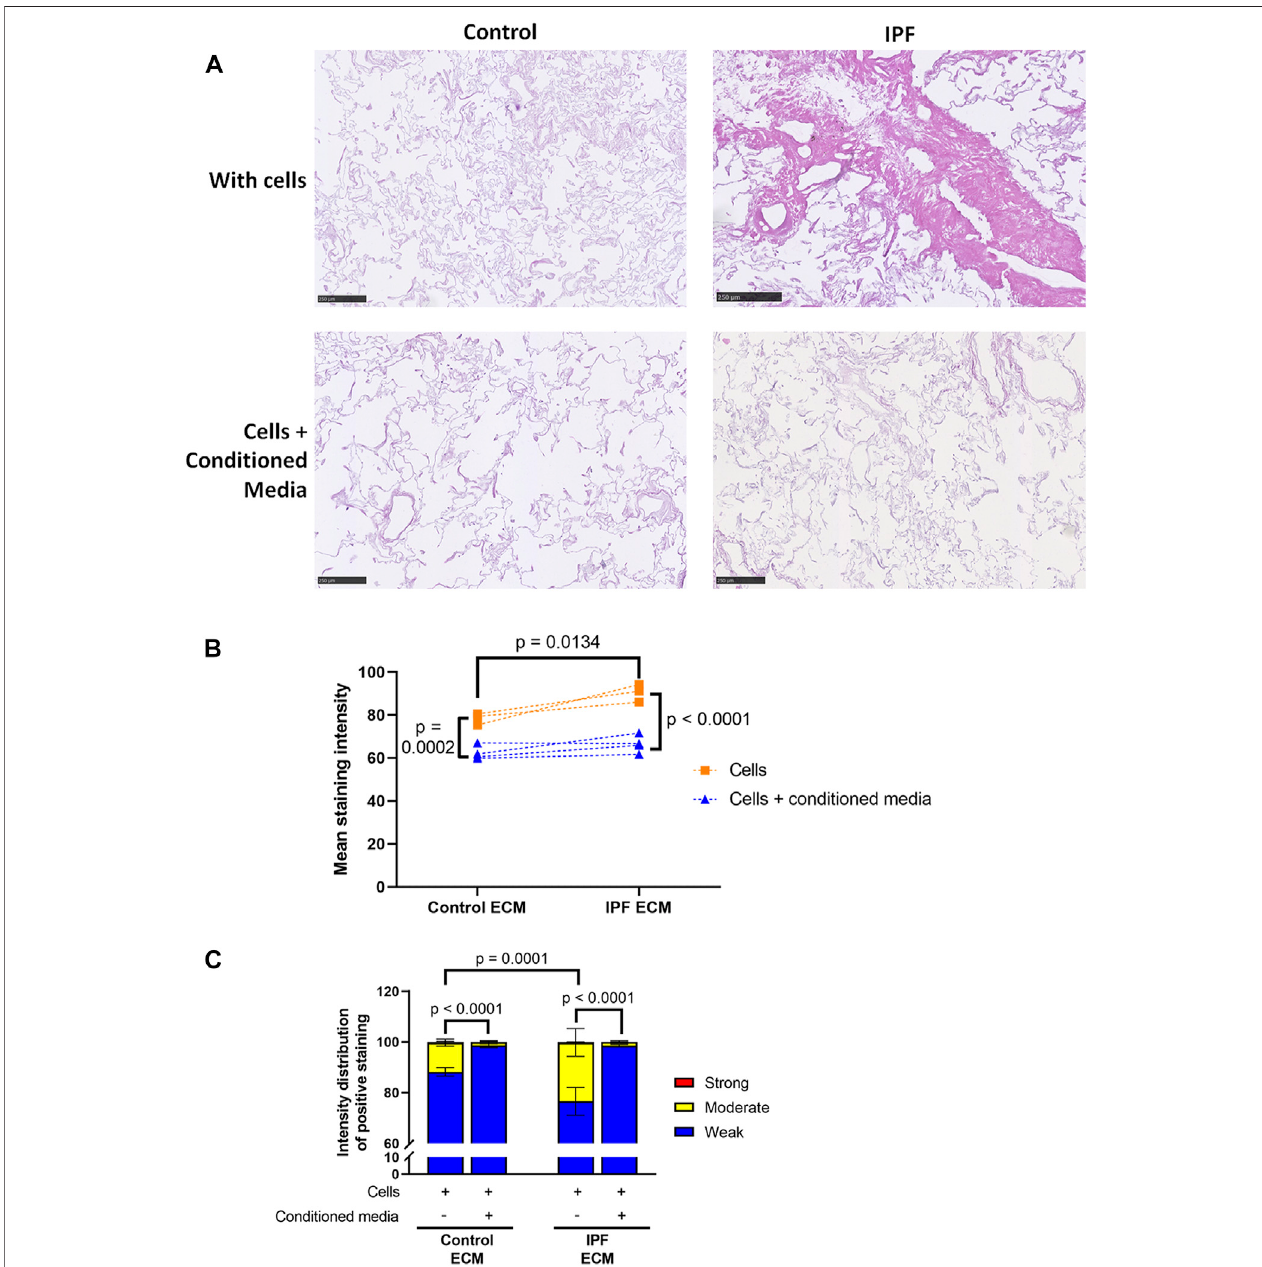
FIGURE5| LessECMdepositioninrecellularizedcontrolandIPFmatricesuponASC-CMtreatment.Primarylung fi broblastswereseededintodecellularizedmatrices and cultured in the absence or presence of ASC-CM for 7 days. Sections of recellularized lung tissue were stained with haematoxylin (blue) and eosin (pink). (A) Representative images of the stained recellularized matrices, showing a magni fi ed part of the whole tissue section. Scale bar (cid:2) 250 μ m. (B) Quanti fi cation of the H&E staining,showingthemeanstainingintensity. (C) Quanti fi cationoftheintensitydistributionofthestaining.Groupswerecomparedusingatwo-wayANOVAfollowedby the original FDR method ofBenjamini and Hochberg as a post-hoc test. p < 0.05was considered signi fi cant. All matrices are derived from the same control and IPF donor, primary lung fi broblasts were obtained from three different control donors ( n (cid:2) 3, dots connected per n ).